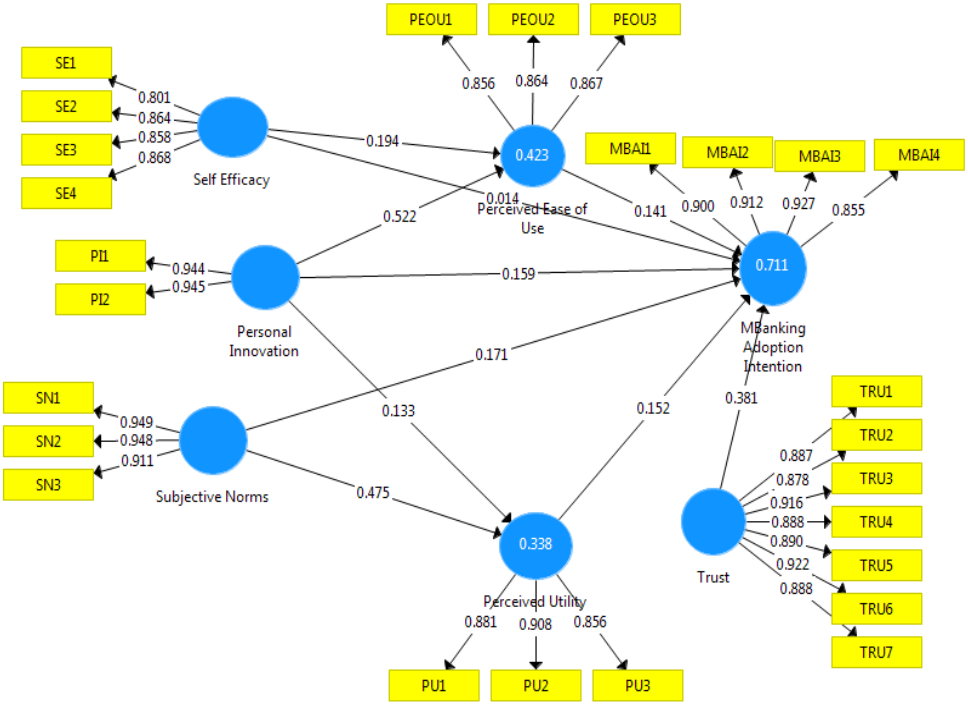
Figure 2. Structural Model of the Study.